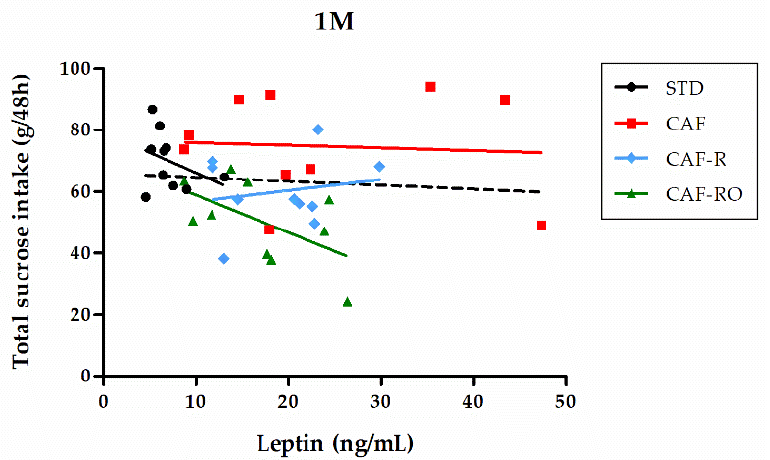
Figure 6. Correlation between serum leptin levels and total sucrose intake at the 1 M concentration. Solid lines represent the correlation trend line for each group ( n = 10) and dashed line represents the correlation line for all animals in the study ( n =